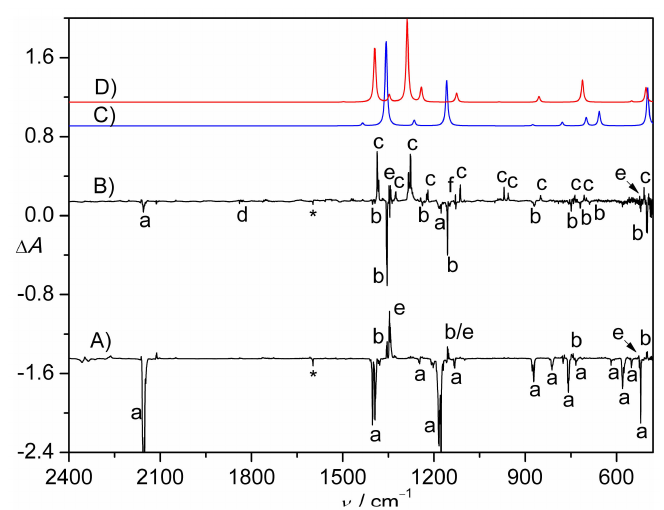
Figure 1. ( A ) IR difference spectrum (Absorbance, ∆ A ) showing the decomposition of CH 2 ClS(O) 2 N 3 in N 2 -matrix upon a 193 nm laser photolysis (30 min); ( B ) IR difference spectrum (Absorbance, ∆ A ) showing the change of the N 2 -matrix upon subsequent UV-light photolysis (365 nm, 8 min). For clarity, spectrum B is 12-fold expanded along the ∆ A axis. ( C ) Calculated IR spectrum of triplet CH 2 ClS(O) 2 N at the B3LYP/6-311++G(3df,3pd) level. ( D ) Calculated IR spectrum of CH 2 ClNSO 2 at the B3LYP/6-311++G(3df,3pd) level. The IR bands of CH 2 ClS(O) 2 N 3 (a), CH 2 ClS(O) 2 N (b), CH 2 ClNSO 2 (c), CH 2 ClS(O)NO (d), SO 2 (e), unknown species (f), and impurity H 2 O (*) are labeled. For clarity, the spectra are arbitrarily shifted along the ∆ A axis.